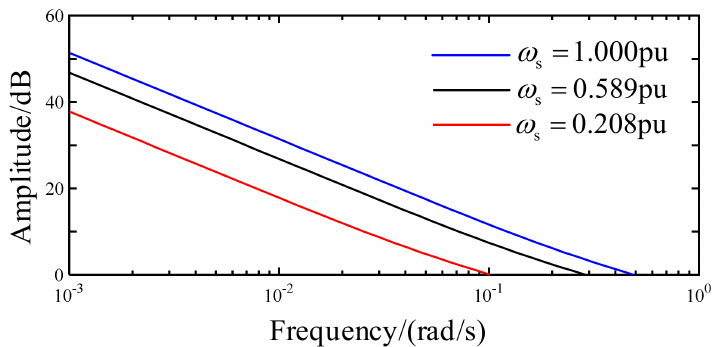
Figure 6. Amplitude–frequency characteristic of asynchronous motor equivalent inertia with varied operating